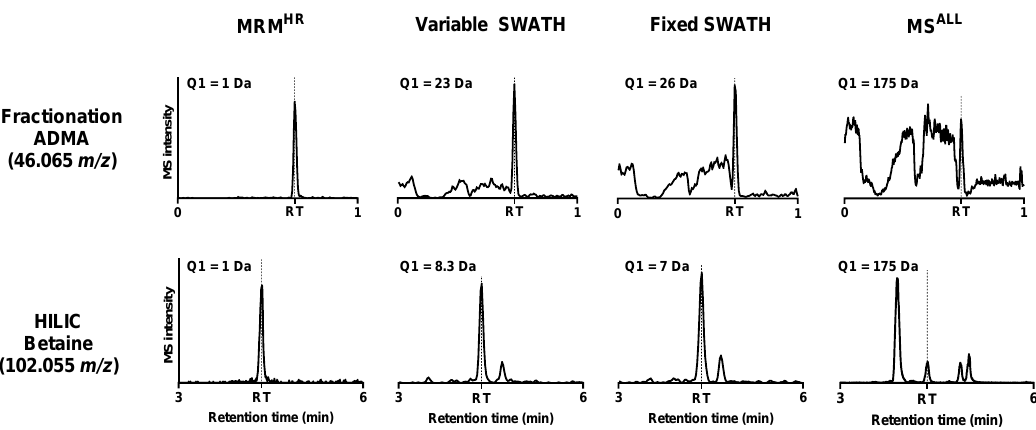
Figure 2. Extracted ion chromatograms of the di ff erent types of MS / MS scans with corresponding Q1 window sizes measured in positive ionization mode. The extraction width is 0.02 m / z . Fluctuating baselines can be observed in the fractionation method with increasing Q1 window sizes. Multiple peaks can be seen in HILIC with increasing Q1 window sizes.